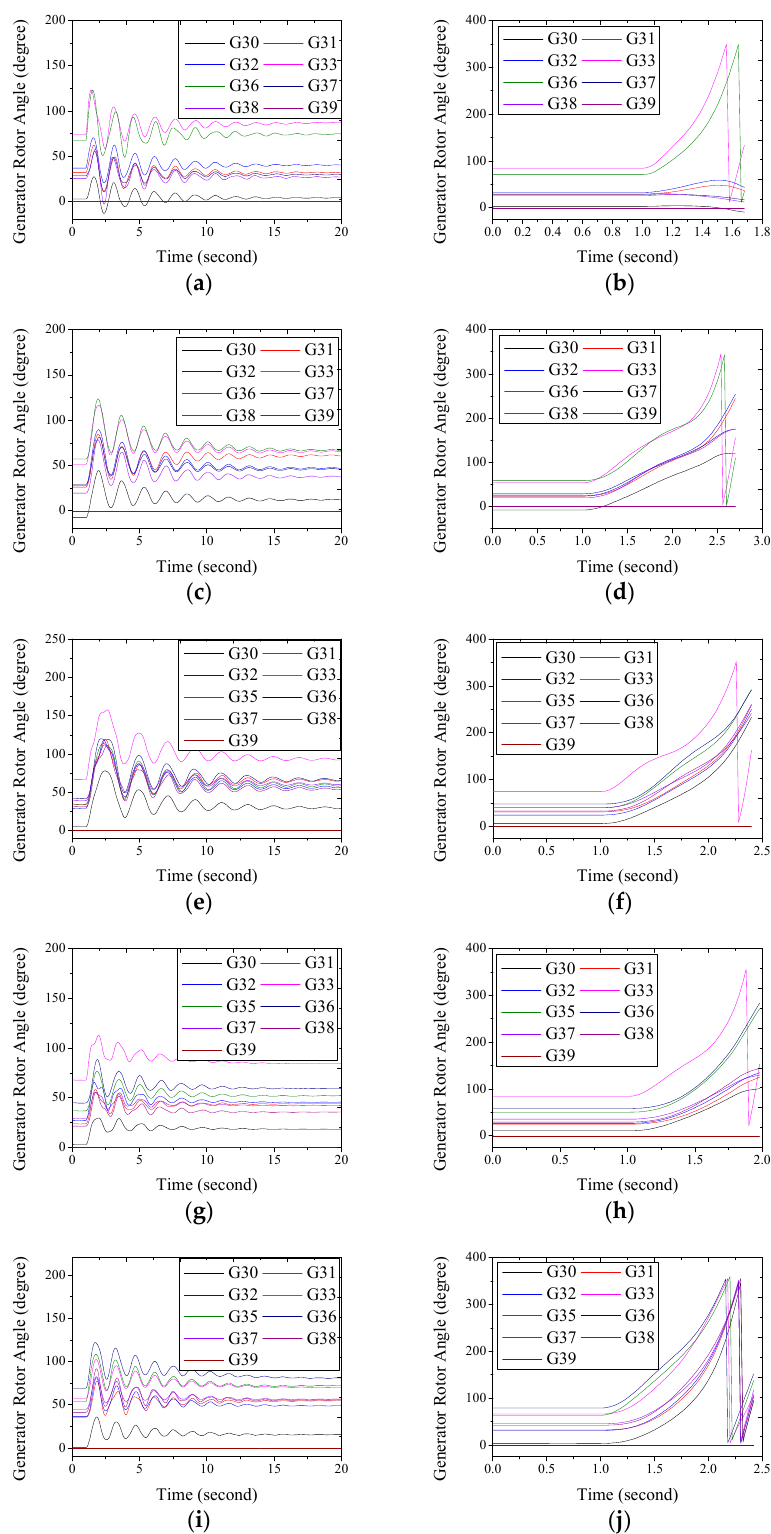
Figure 5. The post-contingency trajectories under different planning schemes. ( a ) Stage 1 under Scheme 1. ( b ) Stage 1 under Scheme 2. ( c ) Stage 2 under Scheme 1. ( d ) Stage 2 under Scheme 2. ( e ) Stage 3 under Scheme 1. ( f ) Stage 3 under Scheme 2. ( g ) Stage 4 under Scheme 1. ( h ) Stage 4 under Scheme 2. ( i ) Stage 5 under Scheme 1. ( j ) Stage 5 under Scheme